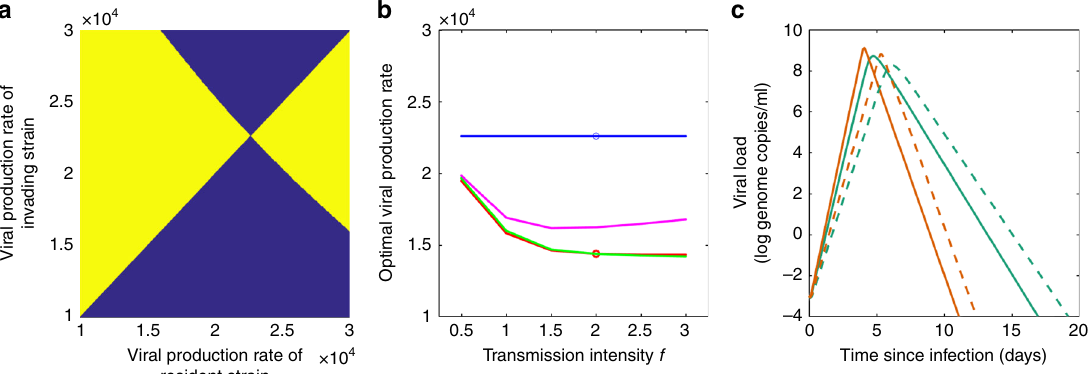
Fig. 4 Evolutionary stable viral production rates depend on epidemiological context. a Pairwise invasibility plot for a population with a single endemically circulating serotype. The x axis plots viral production rates of the resident dengue strain; the y axis plots viral production rates of the invading strain. Yellow (blue) regions show viral production rates that can (cannot) successfully invade populations with the resident strain present. The evolutionarily stable strategy occurs at the viral production rate where neither a higher production rate phenotype nor a lower viral production rate phenotype can invade. b Evolutionary stable viral production rates as a function of dengue transmission intensity f . Differences in transmission intensities re fl ect geographical differences in mosquito densities or biting rates. Optimal viral production rates are shown under two epidemiological contexts: when only a single serotype is circulating (blue line) and when two serotypes are circulating. For the two serotype scenarios, we show optimal viral production rates in the absence of heterologous cross-protection (red line), when the period of “ classical ” cross-protection is assumed to be 2 years long (green line), and when the period of “ clinical ” cross-protection is assumed to be 2 years long (magenta line). At any transmission intensity setting, the evolutionarily stable viral production rate is lower in a population with two serotypes circulating rather than only one. The open circles denote the evolutionary stable viral production rates used in subplot c . c Within-host dengue virus dynamics, simulated with two evolutionary stable viral production rates. Green lines show primary infection simulations; orange lines show secondary infection simulations. Solid lines show simulations with the optimal viral production rate in the population with one endemically circulating serotype ( ω = 22,600 genome copies per cell per day). Dashed lines show simulations with the optimal viral production rate in the population with two endemically circulating serotypes and no heterologous cross-immunity ( ω = 14,380 genome copies per cell per day). For the sake of completeness, we show secondary infection viral dynamics with the viral production rate that is evolutionary stable in the population with one circulating serotypes, although this epidemiological context does not have secondary